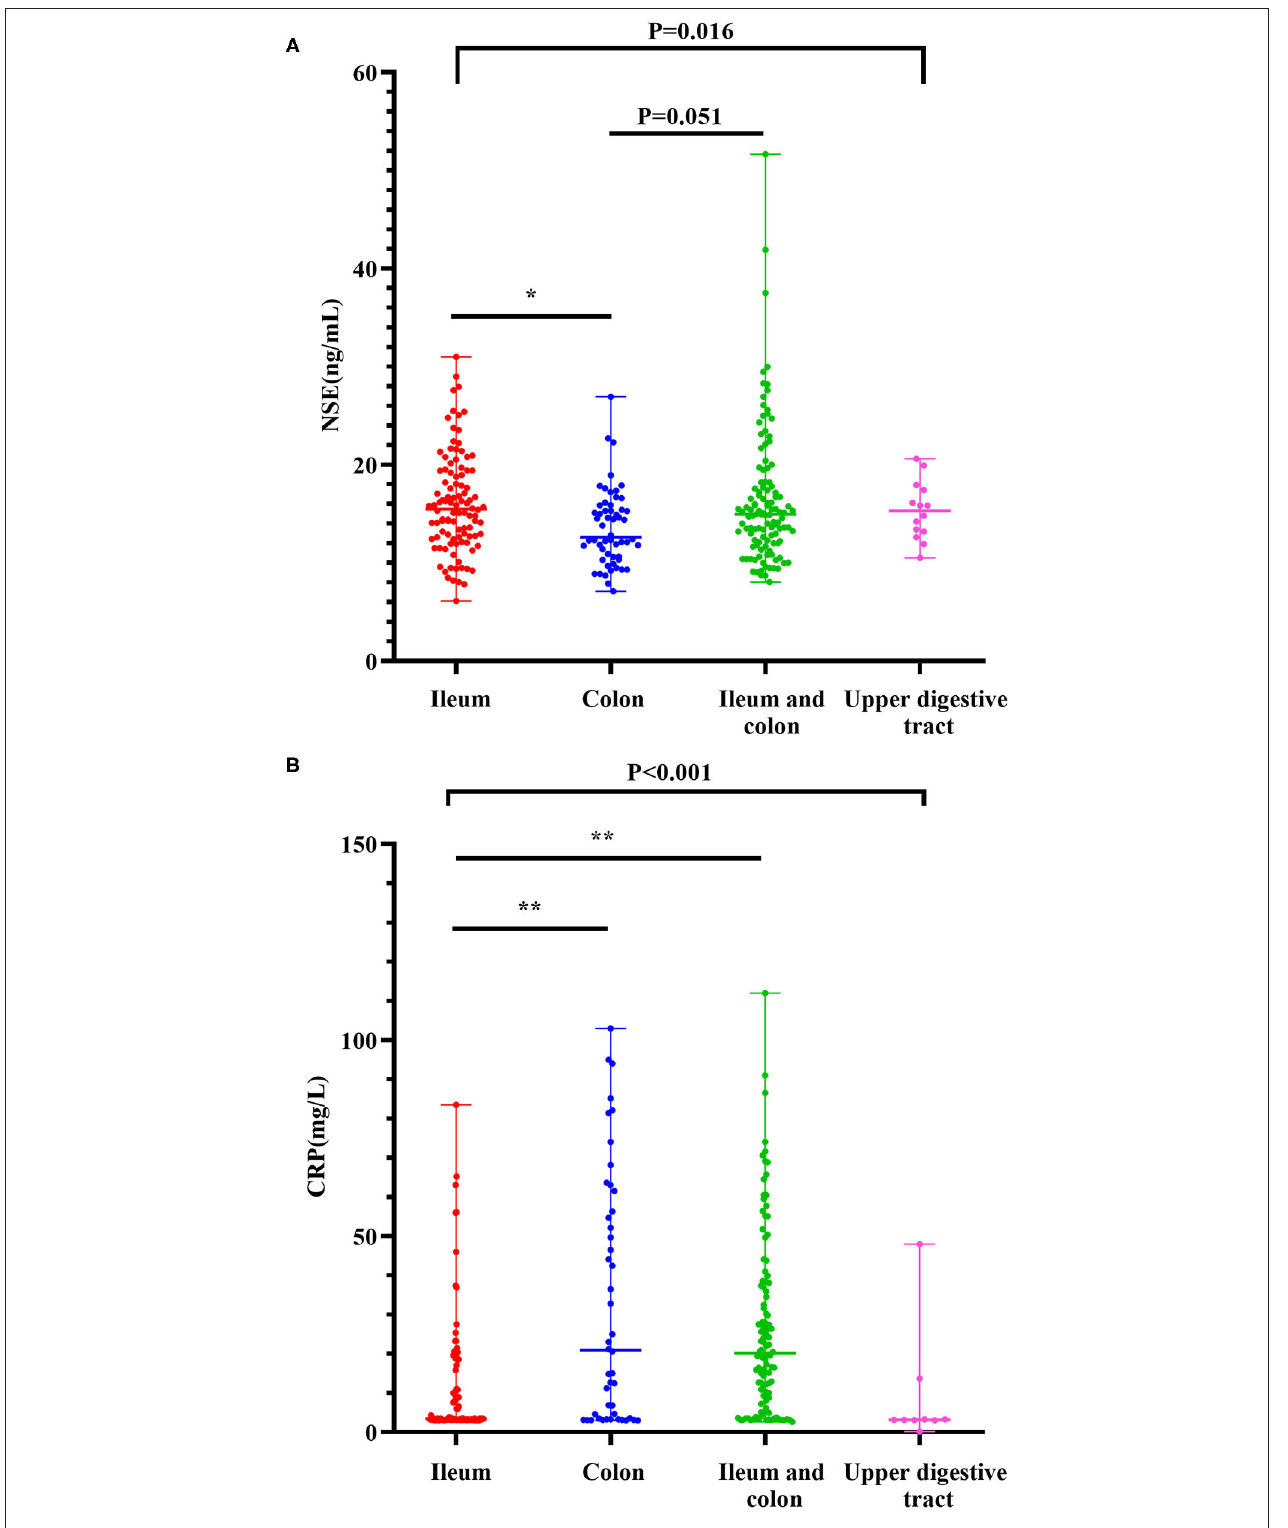
FIGURE 1 | Levels of NSE as per the phenotype of Crohn’s disease (A) . Levels of CRP as per the phenotype of Crohn’s disease (B) . The boxplots show median, upper, and lower quartiles of the data; the whiskers indicate the 95% confidence interval of the values (* P < 0.05 and ** P < 0.001).